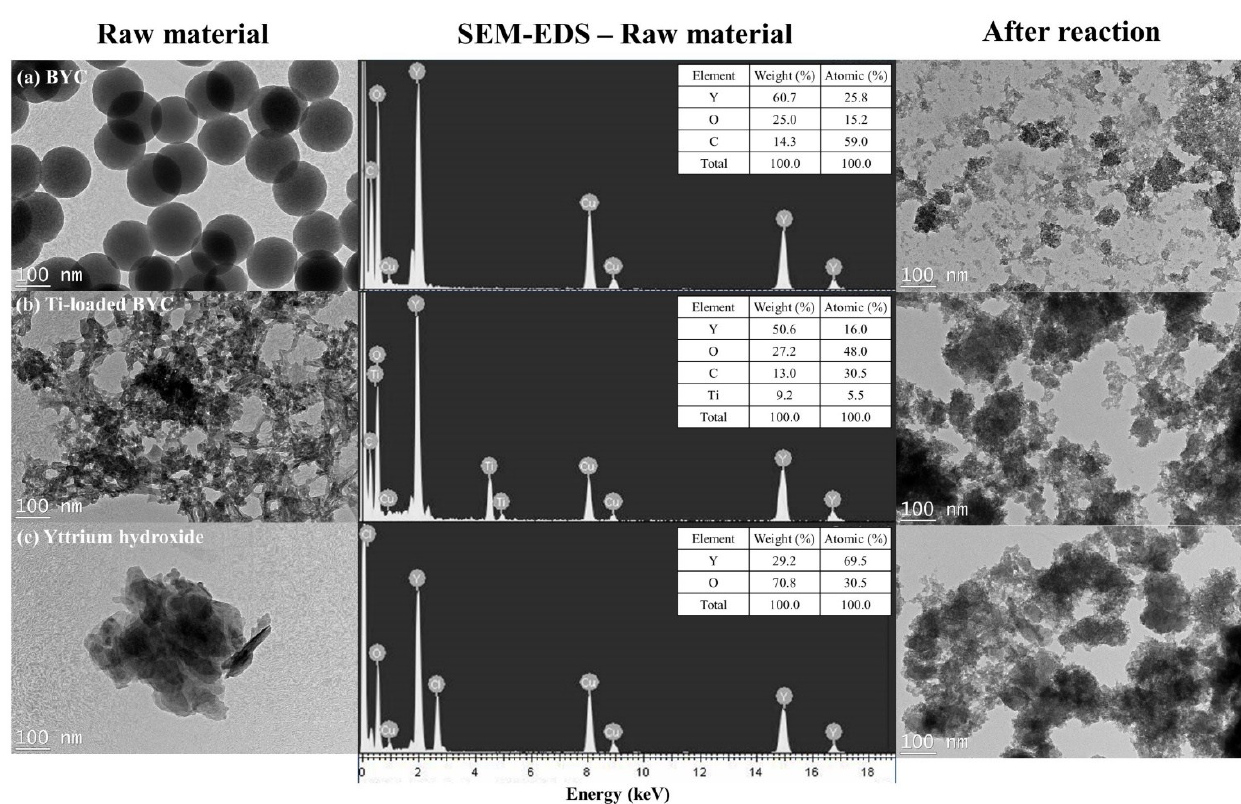
Figure 3. Transmission Electron Microscope images and EDS spectrum of BYC ( a ), 5% Ti-loaded BYC ( b ), and yttrium hydroxide ( c